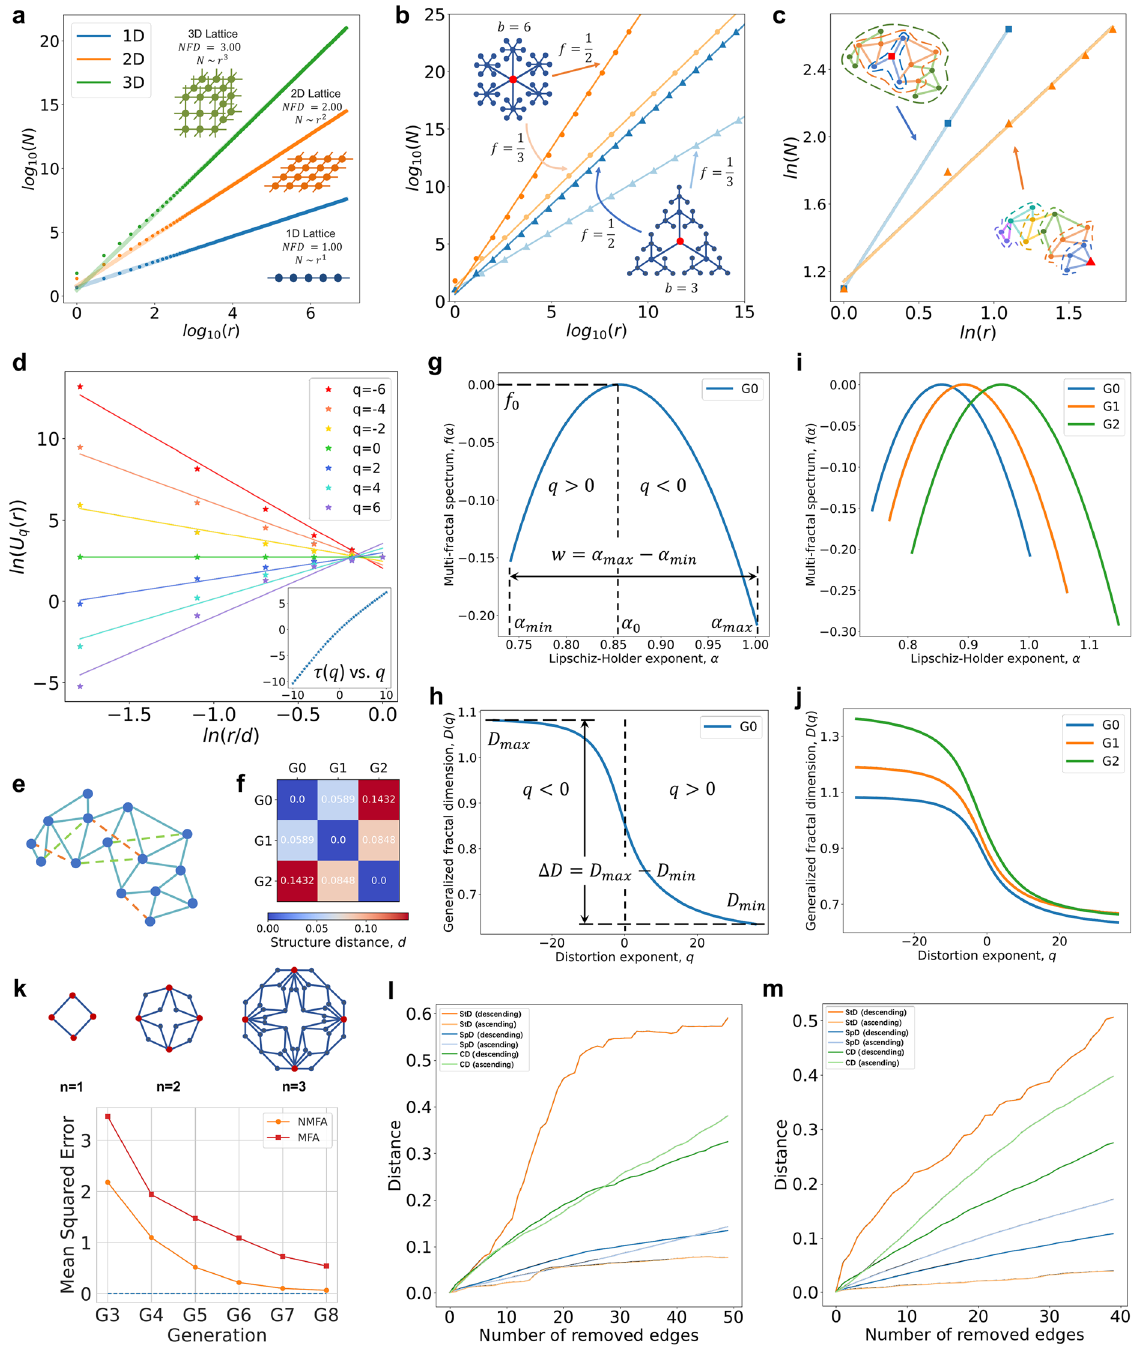
Figure 1. NFD and NMFA quantify the network structure and reveal their generating rules. ( a,b ) The power-law dependence between the number of nodes ( N ) in the box and the box radius ( r ) centered on the single node quantifies the spatial expansion of the network structure, revealing the generating rules. ( a ) The node in the infinite unweighted networks. ( b ) The origin node of the weighted Sierpinski fractal networks. ( c ) The box-growing method of two different nodes (marked as red square and red triangle, respectively) in the artificial network G0. ( d ) The logarithmic relationship between the partition function and the observation scale, and the non-linear relationship between the mass exponent τ( q ) and q . ( g,h ) the multifractal spectrum ( g ) and the generalized fractal dimension ( h ) of the network G0. ( e ) The network examples. G0 is the network mentioned above composed of blue nodes and edges, we add three edges (orange dashed line) to form G1 and continue to add three edges (green dashed line) to form G2. ( f ) The structure distances between G0, G1, and G2. ( i,j ) The comparisons of the multifractal spectra (i) and the generalized fractal dimensions ( j ) between G0, G1, and G2. ( k ) The mean squared error (MSE) between the mass exponent distributions calculated by MFA and NMFA and the analytical mass exponent distribution of the (u, v)-flower network (u = 2, v = 2). ( l,m ) Three distance methods (i.e., structure distance, spectral distance and correlation distance) comparison using the Ollivier–Ricci curvature and the edge betweenness